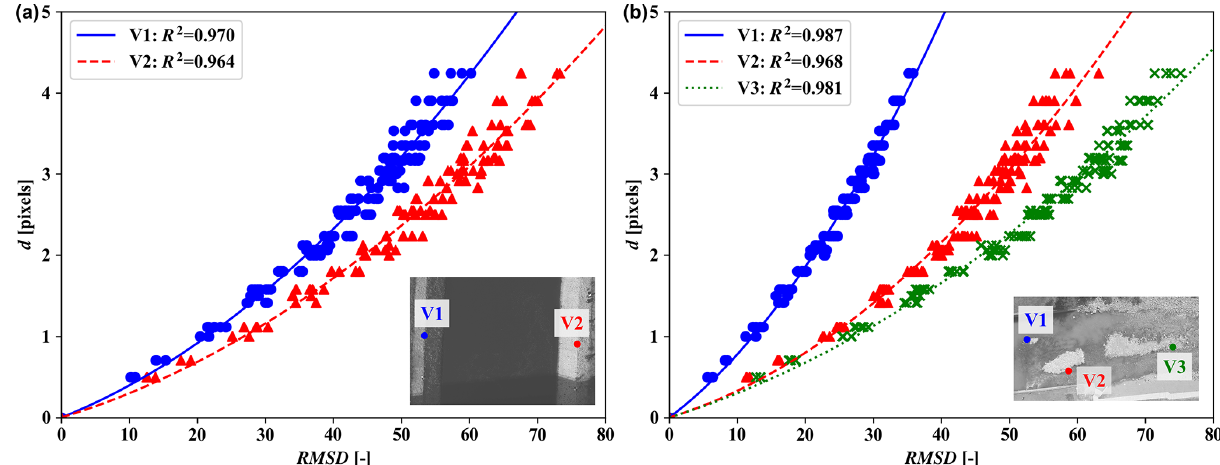
Figure 10. Second-degree polynomial fit of the d (RMSD) relationship for low displacements. (a) Kolubara case study. (b) Alpine case